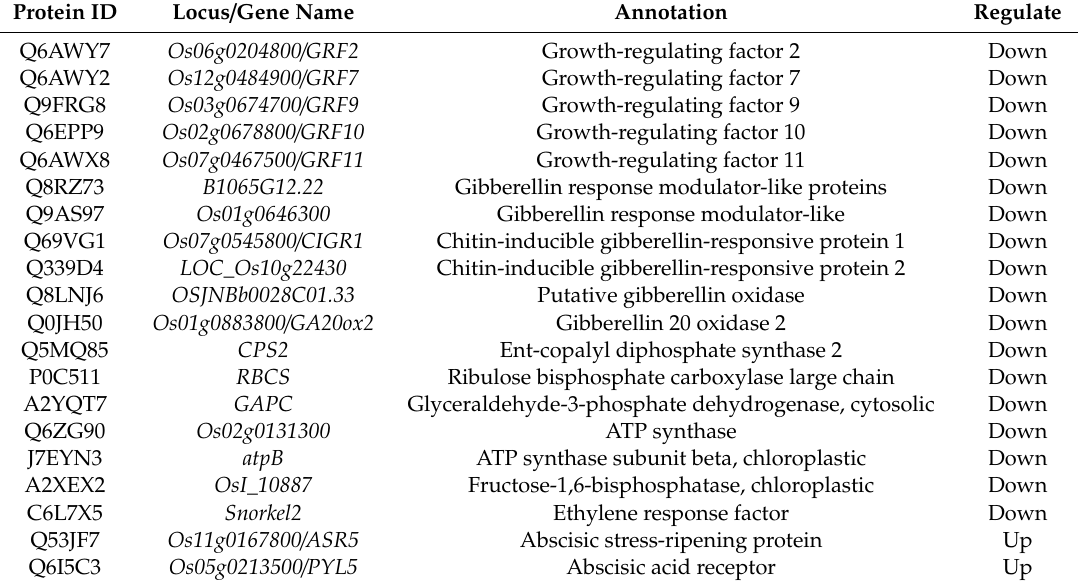
Table 3. Di ff erentially expressed proteins related to GA and plant